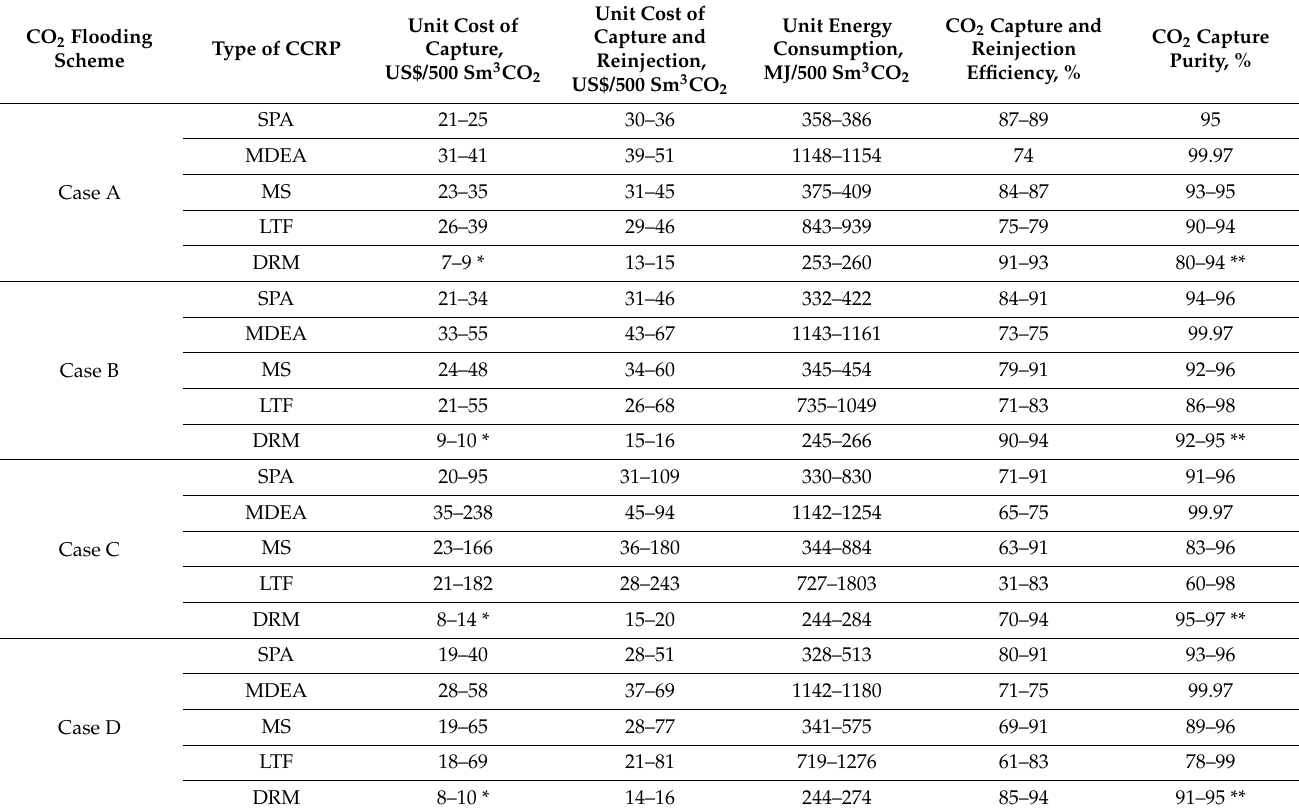
Table 5. Summary of evaluation indicators of all CCRPs of all